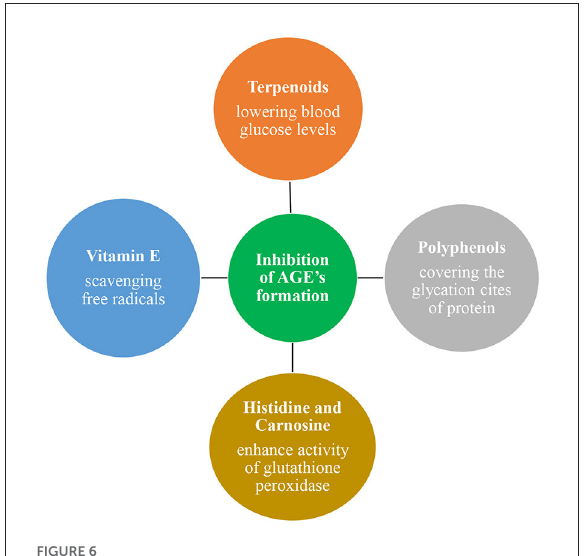
FIGURE6 Vitamin E, Polyphenols, Terpenoids, Histidine, and carnosine have antioxidant and anti-inflammatory properties and protective roles against LDL oxidation and glycation. They protect by scavenging free radicals by covering the glycation sites of protein. And lowers the blood glucose